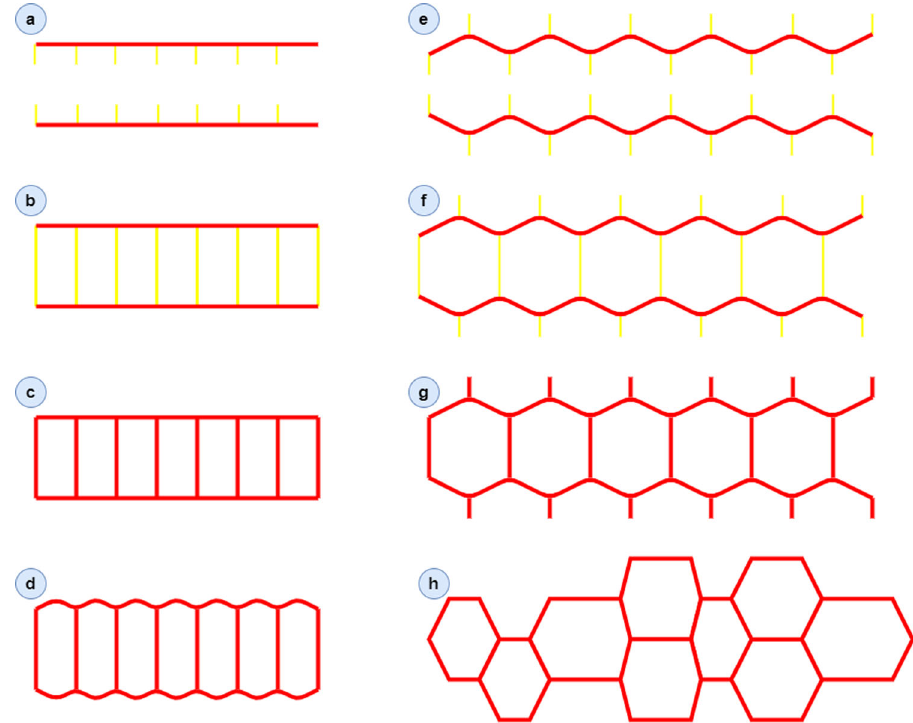
Fig. 4 Sinuous and networked TAR development. Secondary TARs (yellow lines) grow on the main crest (red). Regular growth proceeds from a to b. Reactivation of the primary ridge forms kinked sinuous primary ridges, directly from a to e. Rectangular networked TARs are formed by the growth of secondary ridges between primary ridges that do not experience kinking ( a – c ). Hexagonal-networked TARs can develop from rectangular networks that develop kinking ( c , d ) or from sinuous TARs ( e – g ). In this conceptualization, d and g are essentially equivalent forms with disparate origins. Over time, the hexagonal networks become more irregular ( h ) and the original primary/secondary ridge structure is lost.